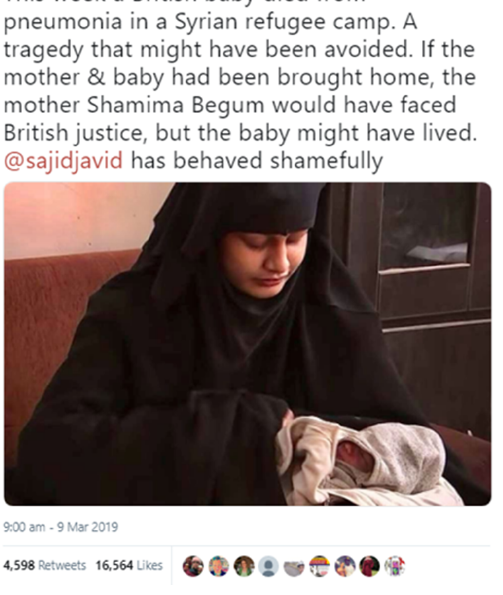
Figure 4. Tweet from Shadow Home Secretary Diane Abbott, 9 March 2019.